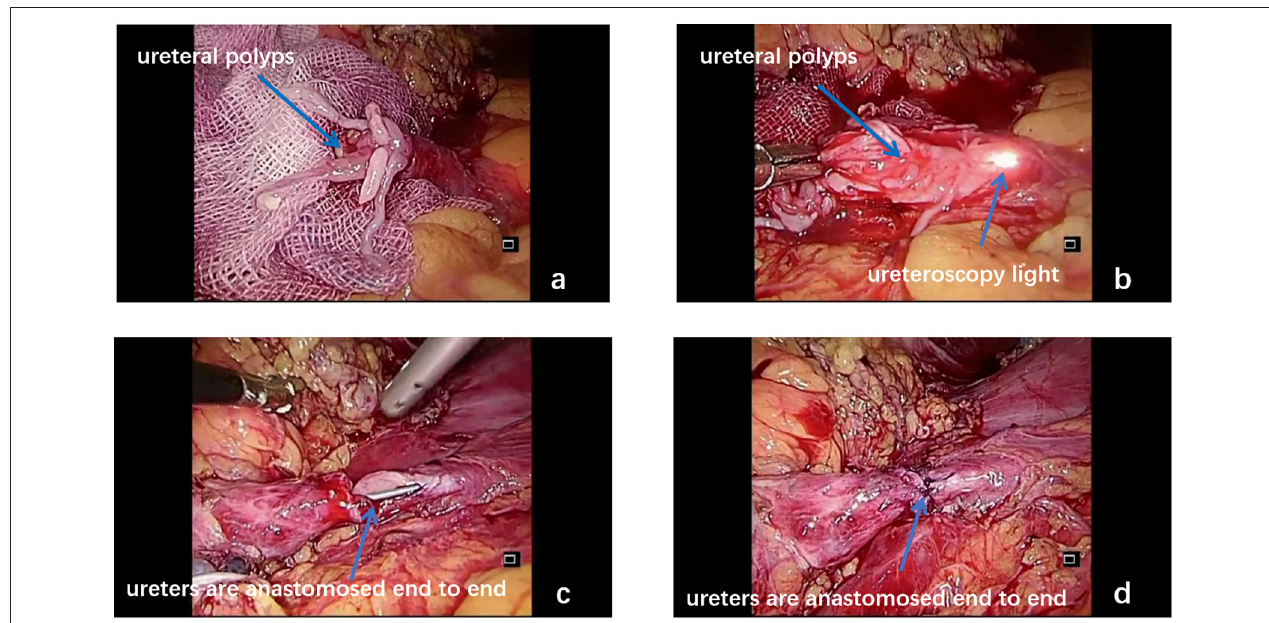
FIGURE 3 | Ureteral polyps bulged out from the upper end of the ureter ( a , blue arrow). Under the combination of the laparoscope and ureteroscope, the diseased ureteral segment is dissected longitudinally and then completely removed ( b , blue arrow). The end-to-side anastomosis of the ureter is performed under laparoscopic guidance ( c,d , blue